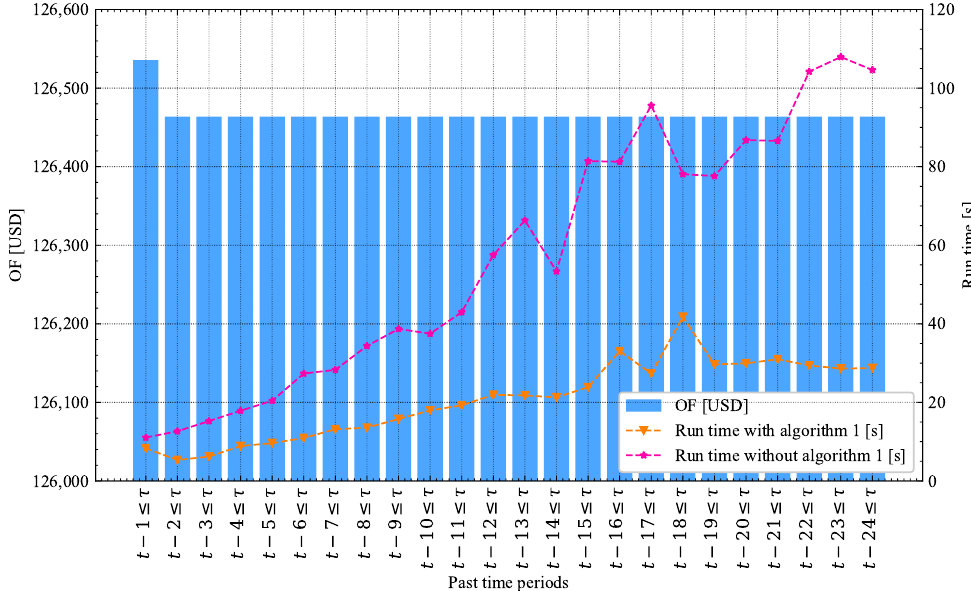
Figure 3. OF value and solution time vs. number of past time information, 6-bus